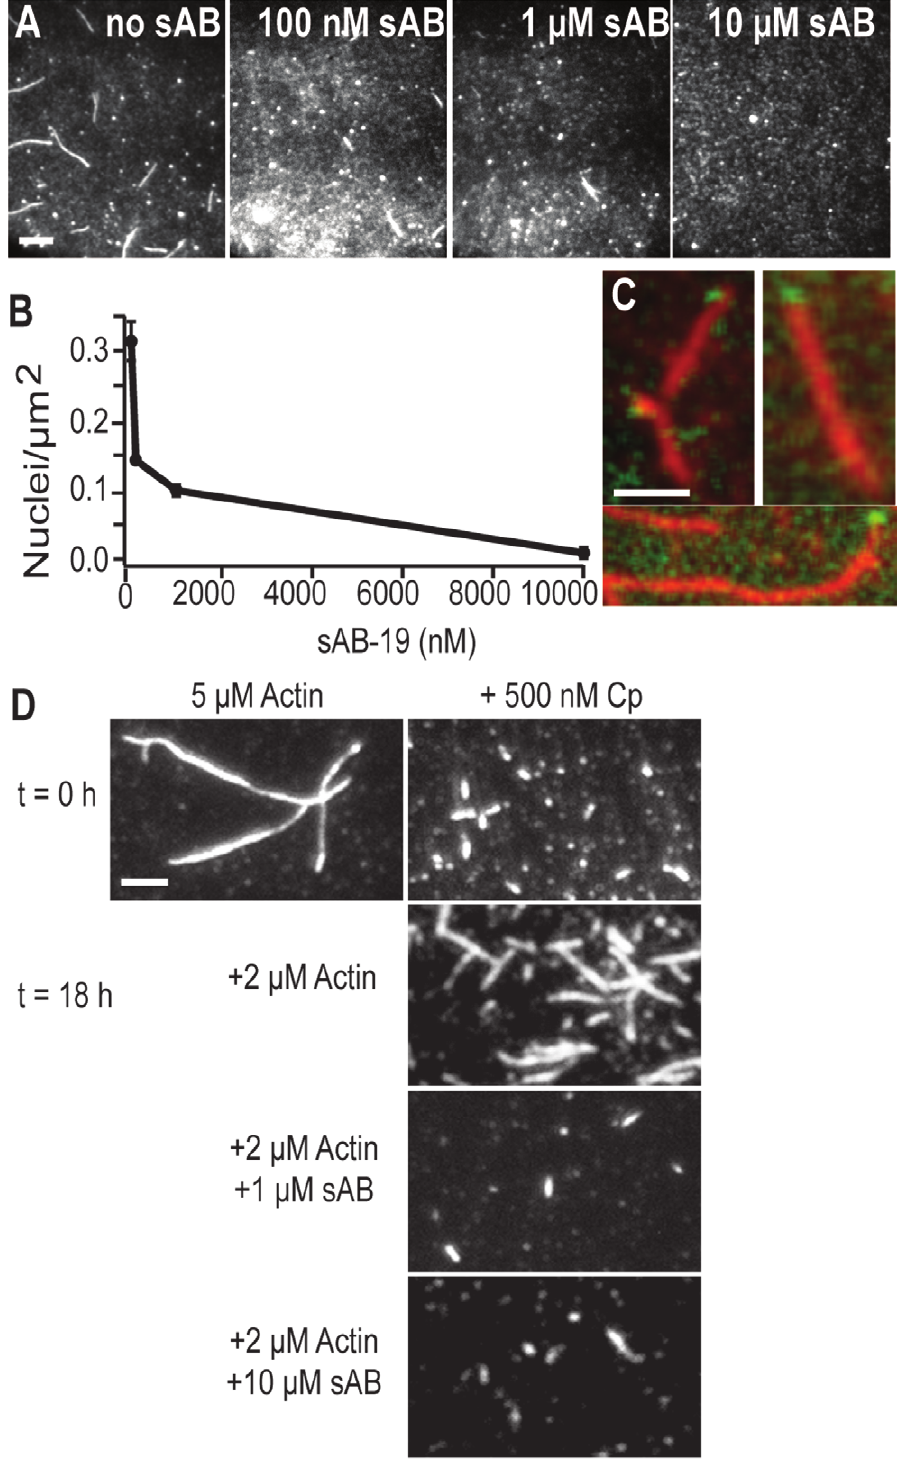
Figure 2. sAB-19 caps the pointed end of actin. (A) Visualization of actin nuclei present in TIRF microscopy after 5 minutes of polymerization. We counted only oblong objects as nuclei. In the absence of sAB-19, we observe more actin nuclei, and nuclei decrease as the sAB-19 concentration is increased. (B) Quantification of the number of actin nuclei found after 5 min as the sAB-19 concentration is increased. (C) TMR-labeled actin filaments (red) in the presence of Cy5-labeled sAB-19 (green). The sAB-19 binds to one end of the actin filaments. (D) Seeded polymerization assay in the presence of mouse capping protein (Cp). Actin polymerized in the absence of capping proteins produces long filaments (upper left). F-actin was polymerized with Cp overnight to generate very short actin seeds capped on the barbed end and exposed to polymerization on pointed end (upper right). After the seeds were generated, free G-actin (33% TMR) under polymerization conditions was added along with sAB-19 (0, 1, and 10 m M). Additional G-actin allows further polymerization off the pointed end of actin, generating longer Cp-seeded actin. However, the addition of sAB-19 caps this pointed end and blocks polymerization, leaving the short seeds and confirming that sAB-19 binds to the pointed end of actin. doi:10.1371/journal.pone.0013960.g002 PLoS ONE |